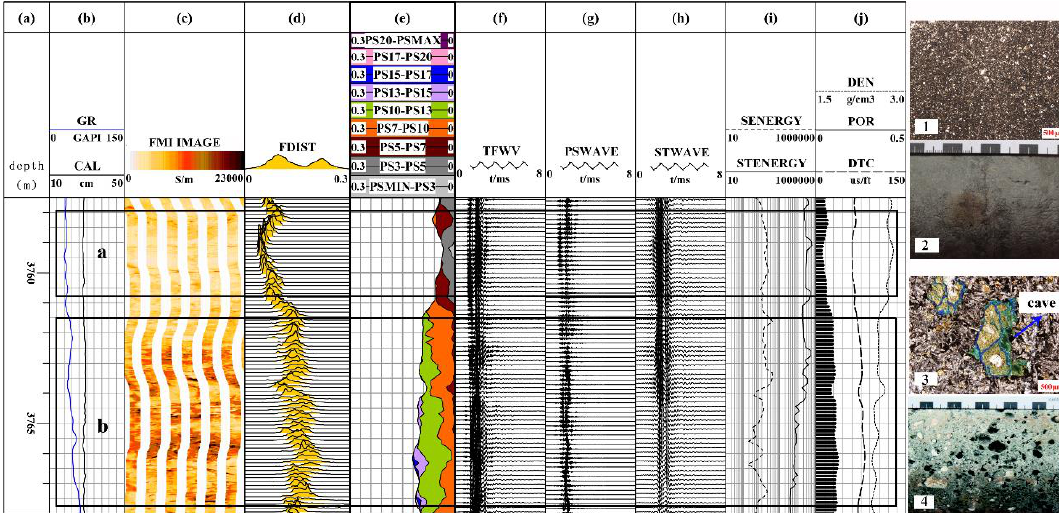
Figure 14. Comprehensive interpretation of logging data in Liaohe igneous formation. ( a ) Depth of the well; ( b ) GR is natural gamma and CAL is caliper; ( c ). FMI IMAGE represents electrical-imaging logging static image; ( d ) FDIST is the porosity-distribution spectrum; ( e ) PSMIN – PSMAX are the porosity of electrical imaging; ( f – h ) TFWV, PSWAVE and STWAVE are the waveforms of full-wave, P, S and ST waves, respectively; ( i ) SENERGY represents the energy of the S-wave. STENERGY is the energy of ST wave; ( j ) DEN is the density of the formation. POR is the porosity by conventional logging. DTC is the slowness of the P-wave. Figures 1 and 2 on the right are the core slice and core of the tight formation. Figures 3 and 4 are the core slice and core of the altered formation.